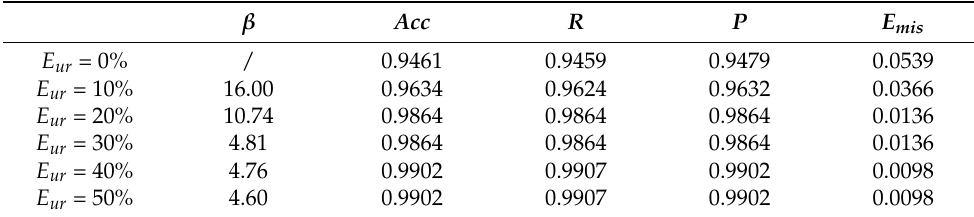
Table 5. Performance of three-way decision on the Iris dataset.